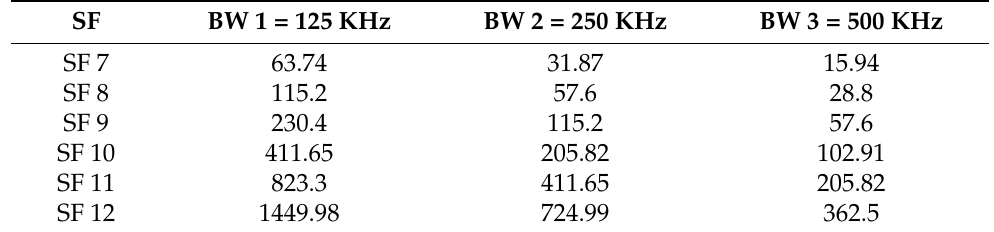
Table 9. ToA (ms) at CR 2.